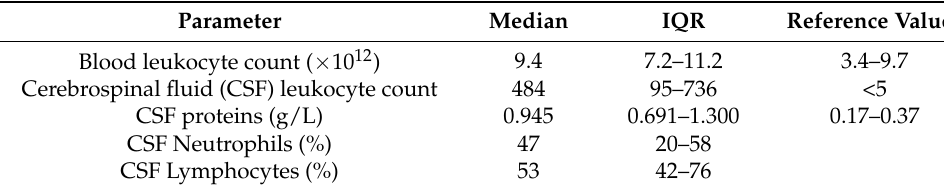
Table 3. Laboratory findings in patients with WNV neuroinvasive disease.